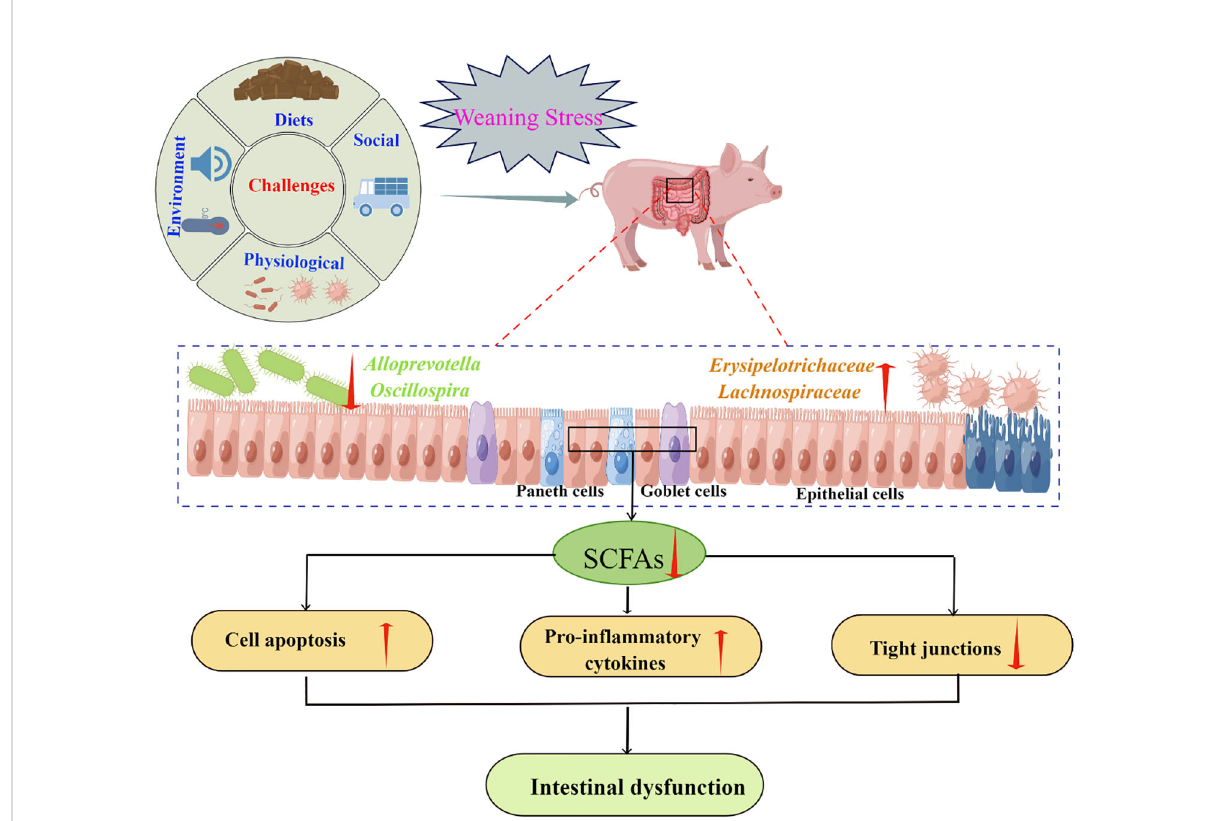
FIGURE 4 Weaning stress may affect intestinal homeostasis through microbial-driven short-chain fatty acids (SCFA) (By Figdraw). Weaning stress caused a reduction in SCFAs producing bacteria, such as Alloprevotella and Oscillospira (141), and an increase in the relative abundances of Erysipelotrichaceae and Lachnospiraceaet which is negatively correlated with butyrate production (121). SCFAs had a good regulatory effect on cell apoptosis (153), anti-in fl ammatory factors secretion (154), and tight junction proteins expression (155). Therefore, the intestinal dysfunction caused by weaning stress may be related to the secretion of SCFA driven by